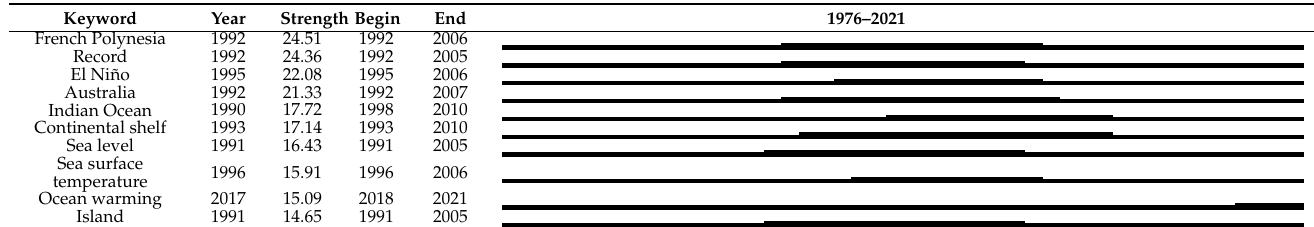
Table 5. Top 10 keywords with the strongest citation bursts.